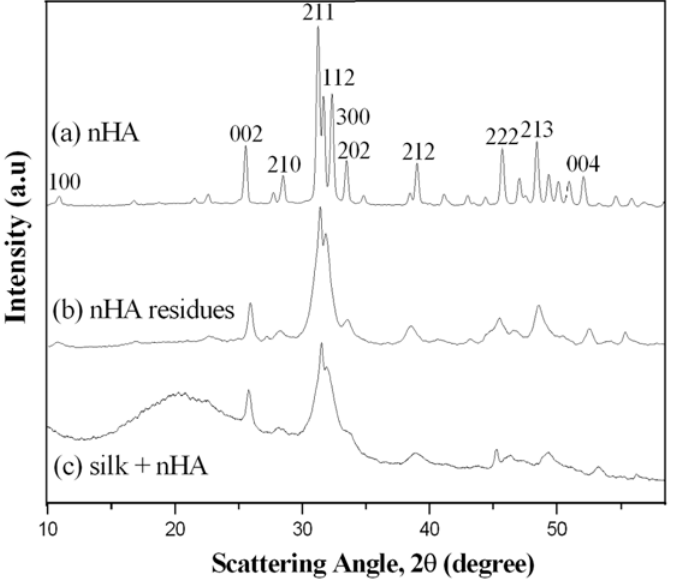
Figure 8. X-ray diffraction (XRD) patterns of ( a ) pure hydroxyapatite (HA) (control); ( b ) nHA residues; and ( c ) mineralized silk/nHA